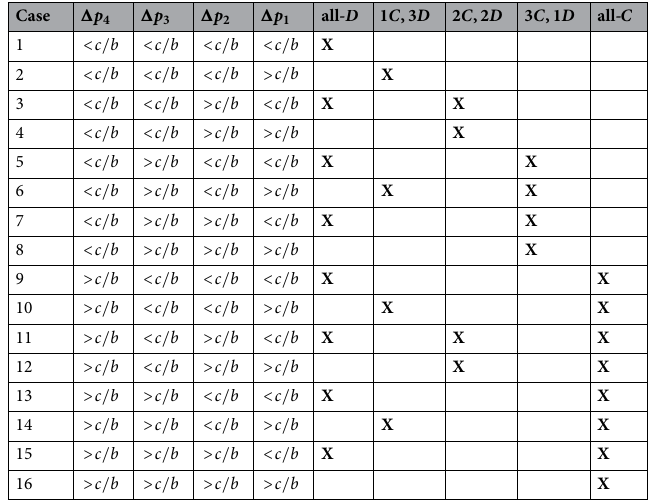
Table 4. Equilibrium strategies of a four-player weightlifting